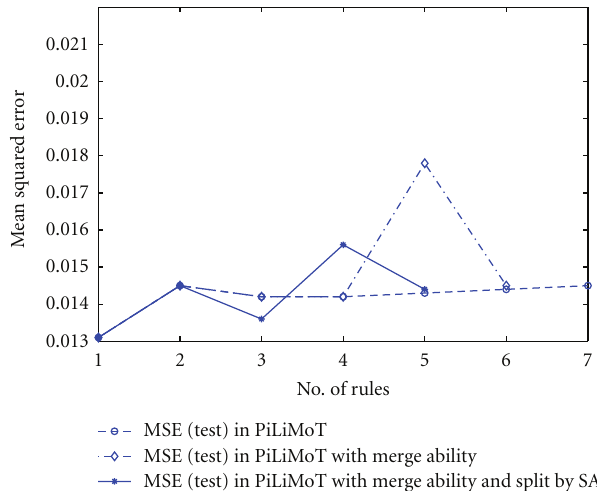
Figure 9: Convergence curves in comparing PiLiMoT, PiLiMoT with Merge ability, and PiLiMoT with Merge ability and modified spilt by SA in test data.